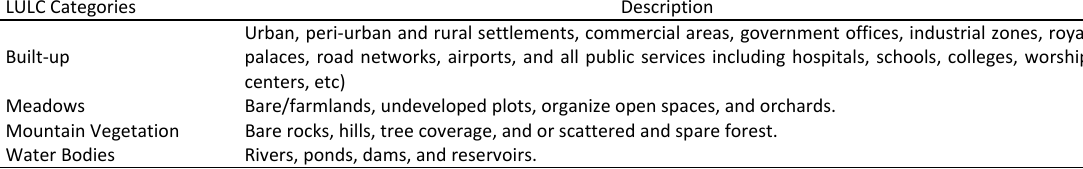
Table 2: Land use and land cover classification